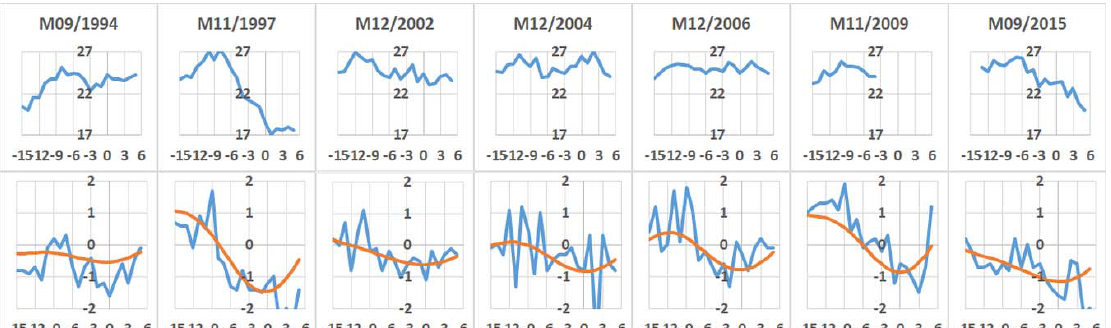
Figure 6. The top plots represent the subsurface water temperature in °C at 2° S 180° W averaged over 125 to 175 m in depth versus the offset in months. The date of occurrence of the event corresponds to the null offset. The bottom plots depict the raw signal SOI (in blue) and that filtered within the band of 1.5/15 years (in red).